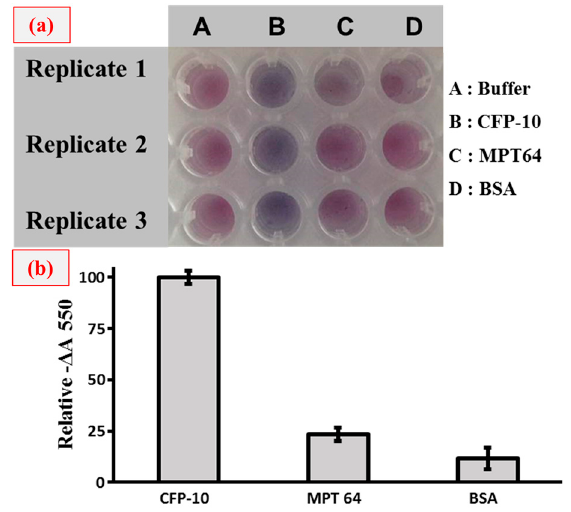
Figure 6. Specificity test of plasmonic ELISA analysis for the CFP-10 detection. ( a ) Naked-eye detection using plasmonic ELISA and ( b ) the relative signal ( −∆ A 550) is expressed as the decrease in absorbance with respect to the blank monitored at 550 nm, corresponding to the CFP-10 target signal response. The plasmonic ELISA was tested to observe the specific binding to CFP-10 and other protein targets (MPT 64 and BSA). For the study, a concentration of 50 ng/mL was applied for each sample.